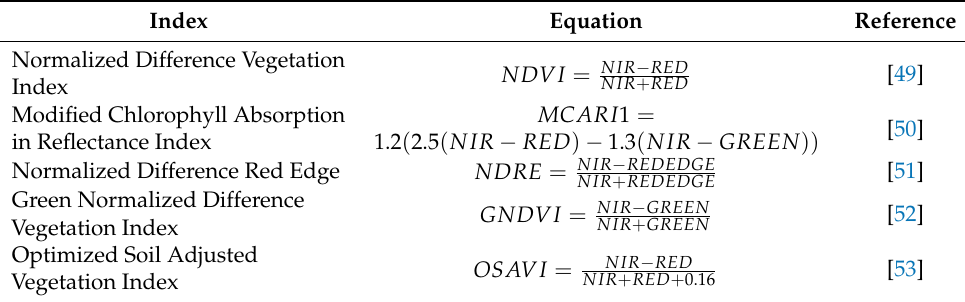
Table 4. Vegetation indices computed from multispectral